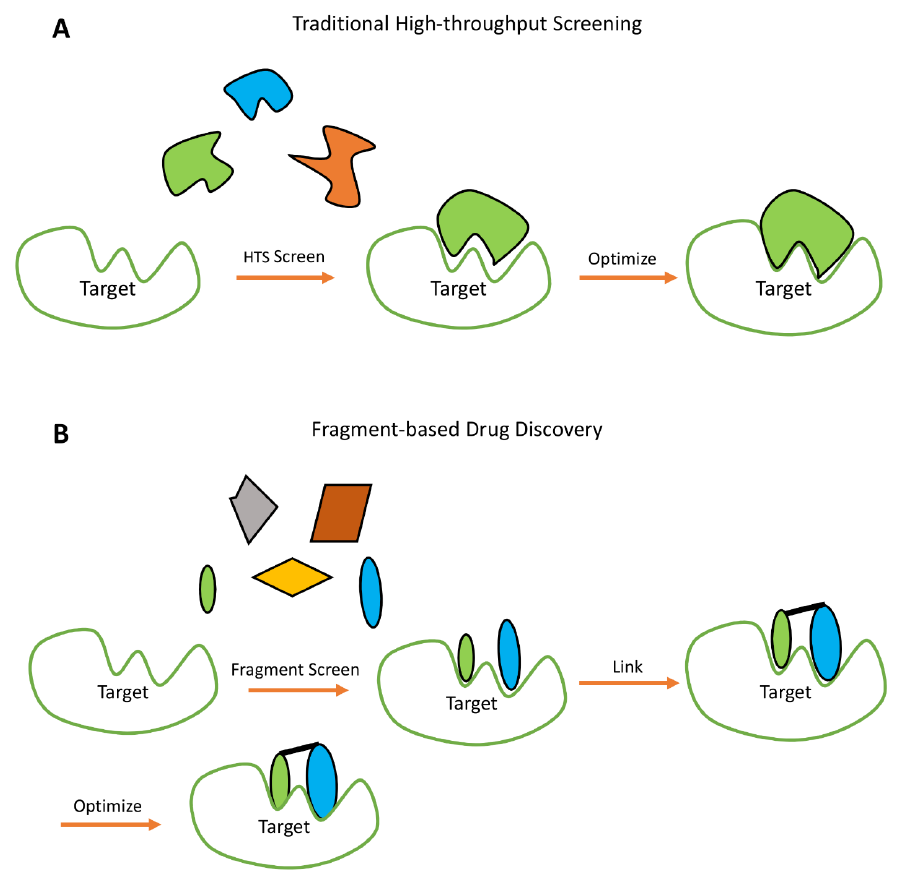
Figure 6. Underlying mechanisms of ( A ) Traditional High-throughput Screening, and ( B ) Fragment Based Drug Discovery.